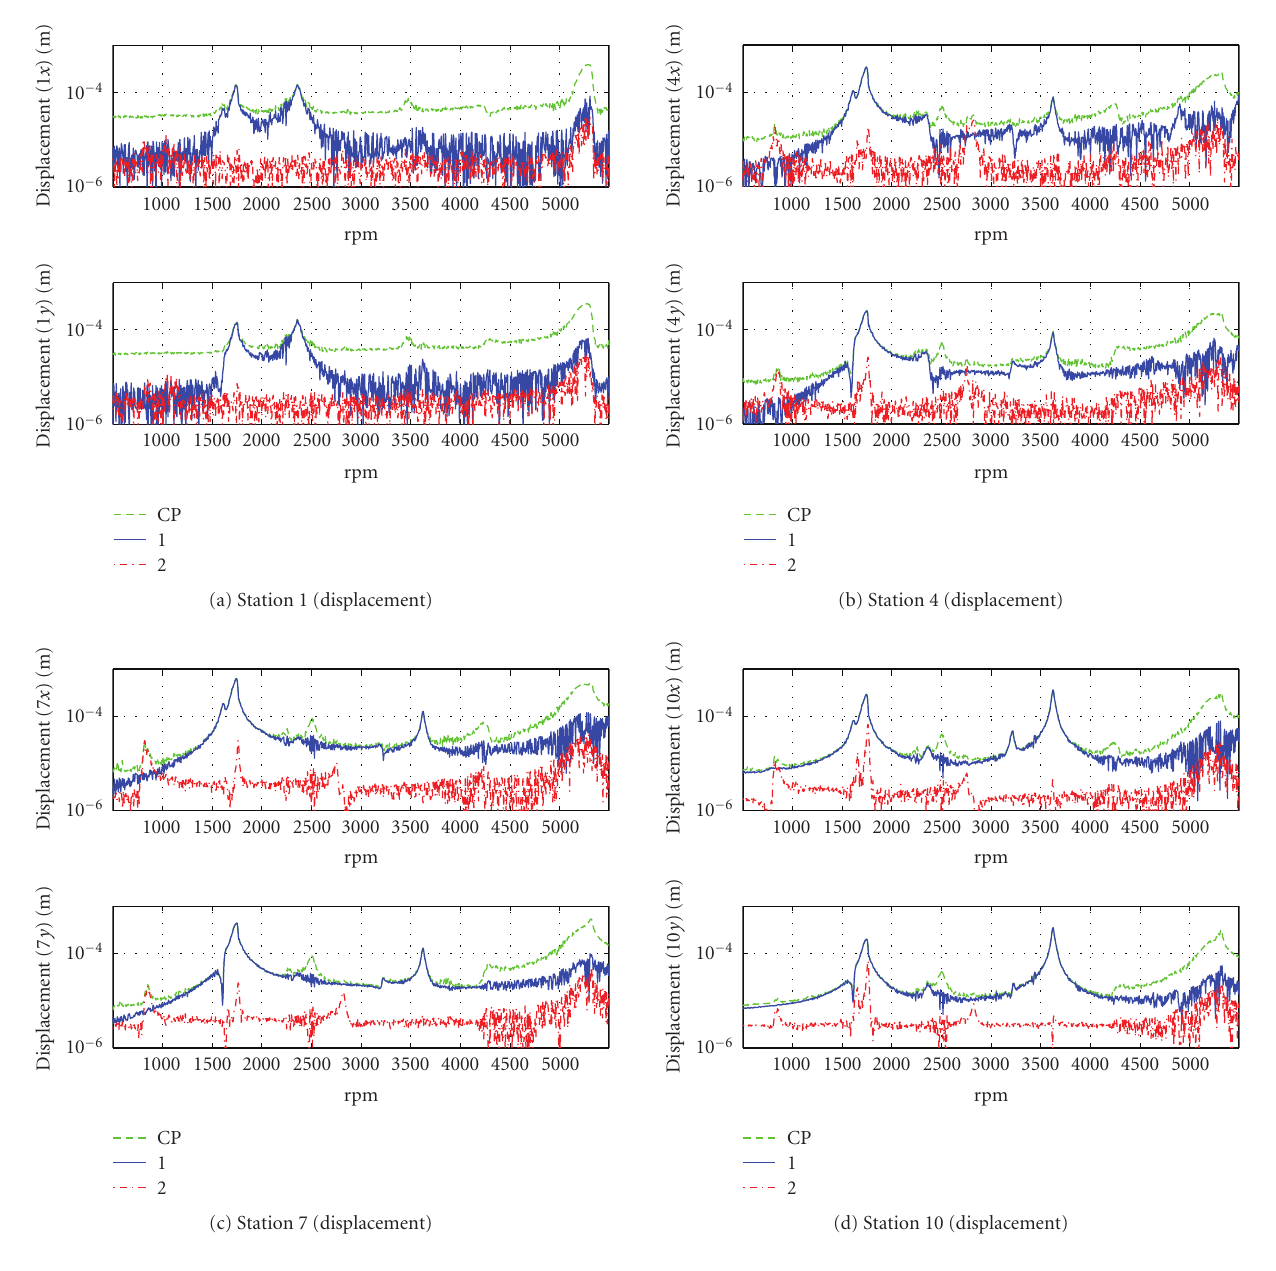
Figure 12: Order tracking measurements (rotor 2 reference, stations 1, 4, 7, and 10).